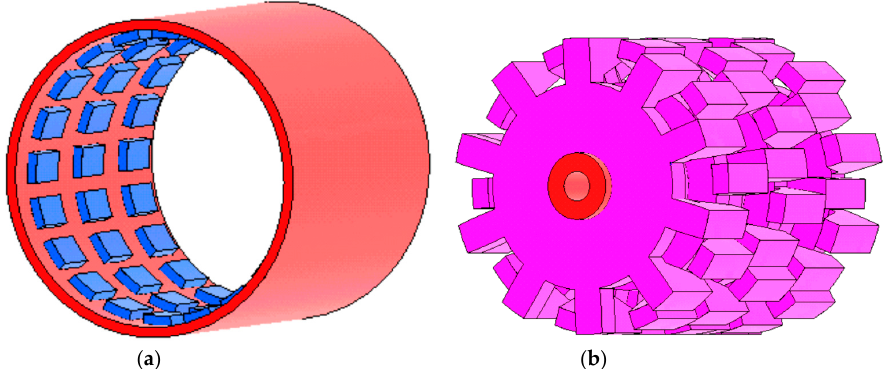
Figure 1. A three-phase claw pole motor: ( a ) outer rotor with three arrays of PMs on the inner surface of the yoke, and ( b ) three-stack stator cores on a shaft.